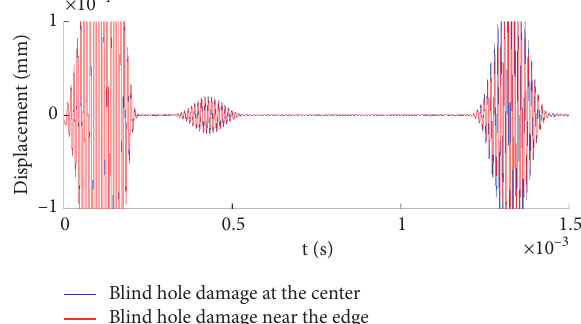
Figure 13: Time domain waveforms received from a hexagonal pipe with blind-hole damages located at the center and near the edge of a plane.